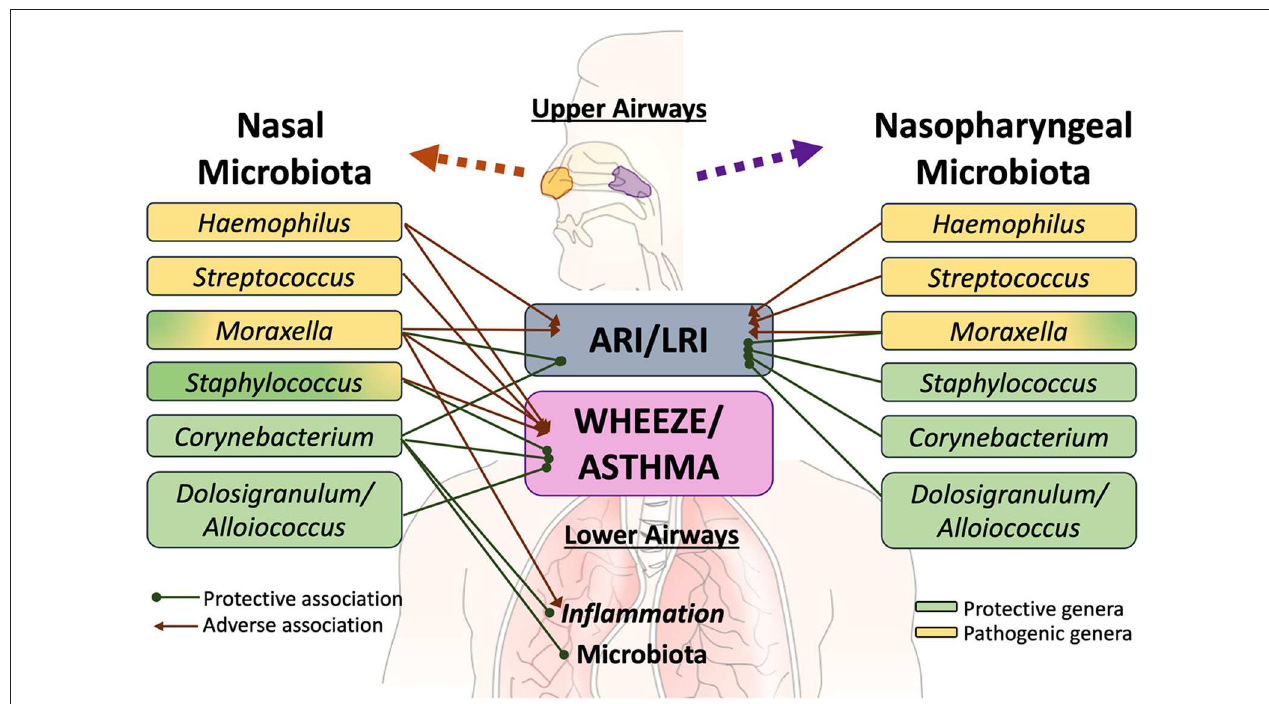
FIGURE 1 | Specific members of the upper airway microbiota have been differentially linked to acute respiratory illness (ARI), including lower respiratory illness (LRI), recurrent wheeze, asthma risk and exacerbation. Although limited, there is some evidence that interactions exist between at least some members of the upper airway microbiota with those colonizing the lower airways and with the pulmonary immune system. However, further work is required to elucidate these